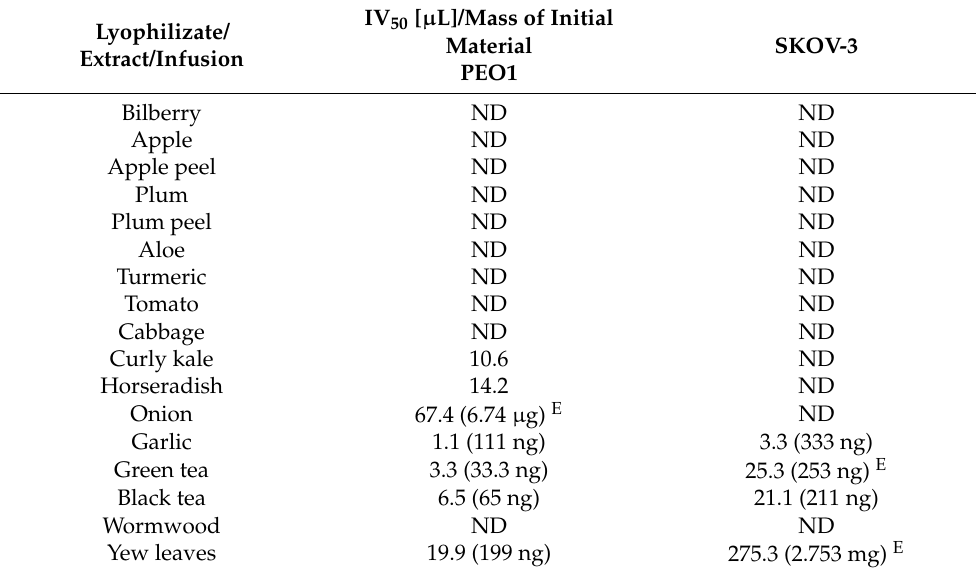
Figure 2. Effect of green and black tea, and of wormwood and yew leaves extract on the proliferation of SKOV-3, PEO1 and MRC-5 cells, estimated with Neutral Red; * p < 0.05. The values of the extract/infusion volumes inhibiting the proliferation of the cells studied in 50% (IV 50 ) and the corresponding amounts of the initial materials are listed in Table 1. The presented data allow the conclusion that the extracts of curly kale, horseradish and garlic as well as green and black tea and infusions of yew leaves had the highest potential to inhibit the proliferation of human ovary cells in vitro. Table 1. Inhibitory volumes of extracts of fruits and vegetables, and of herbal infusions (as well as mass of the initial material) per 100 µL medium on the proliferation of ovary cancer cells.